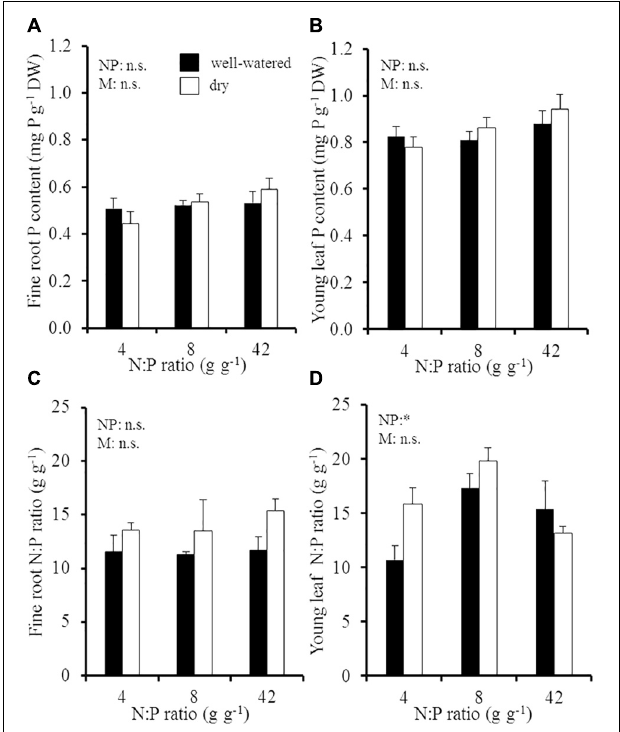
FIGURE 1 | (A) Fine root P concentration, (B) young leaf P concentration, (C) fine root N:P ratio, and (D) young leaf N:P ratio of young Palestine oak ( Quercus calliprinos ) trees grown at increasing soil N:P ratio and decreasing soil moisture in a climate chamber. Shown are means and standard errors for replicate saplings ( n = 48 for P concentrations; n = 24 for N:P ratios). The results of two-way ANOVAs on the significance of the effect of the soil N:P ratio (NP) or soil moisture (M) are indicated by asterisks ( ∗ for p ≤ 0.05; n.s., not significant).